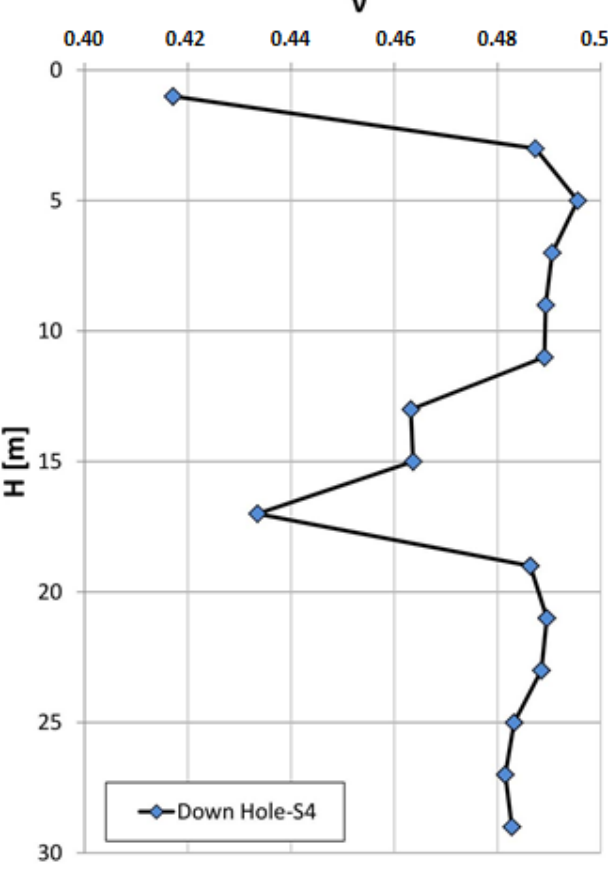
Figure 7. Poisson ratio from the Down Hole test (borehole S4).